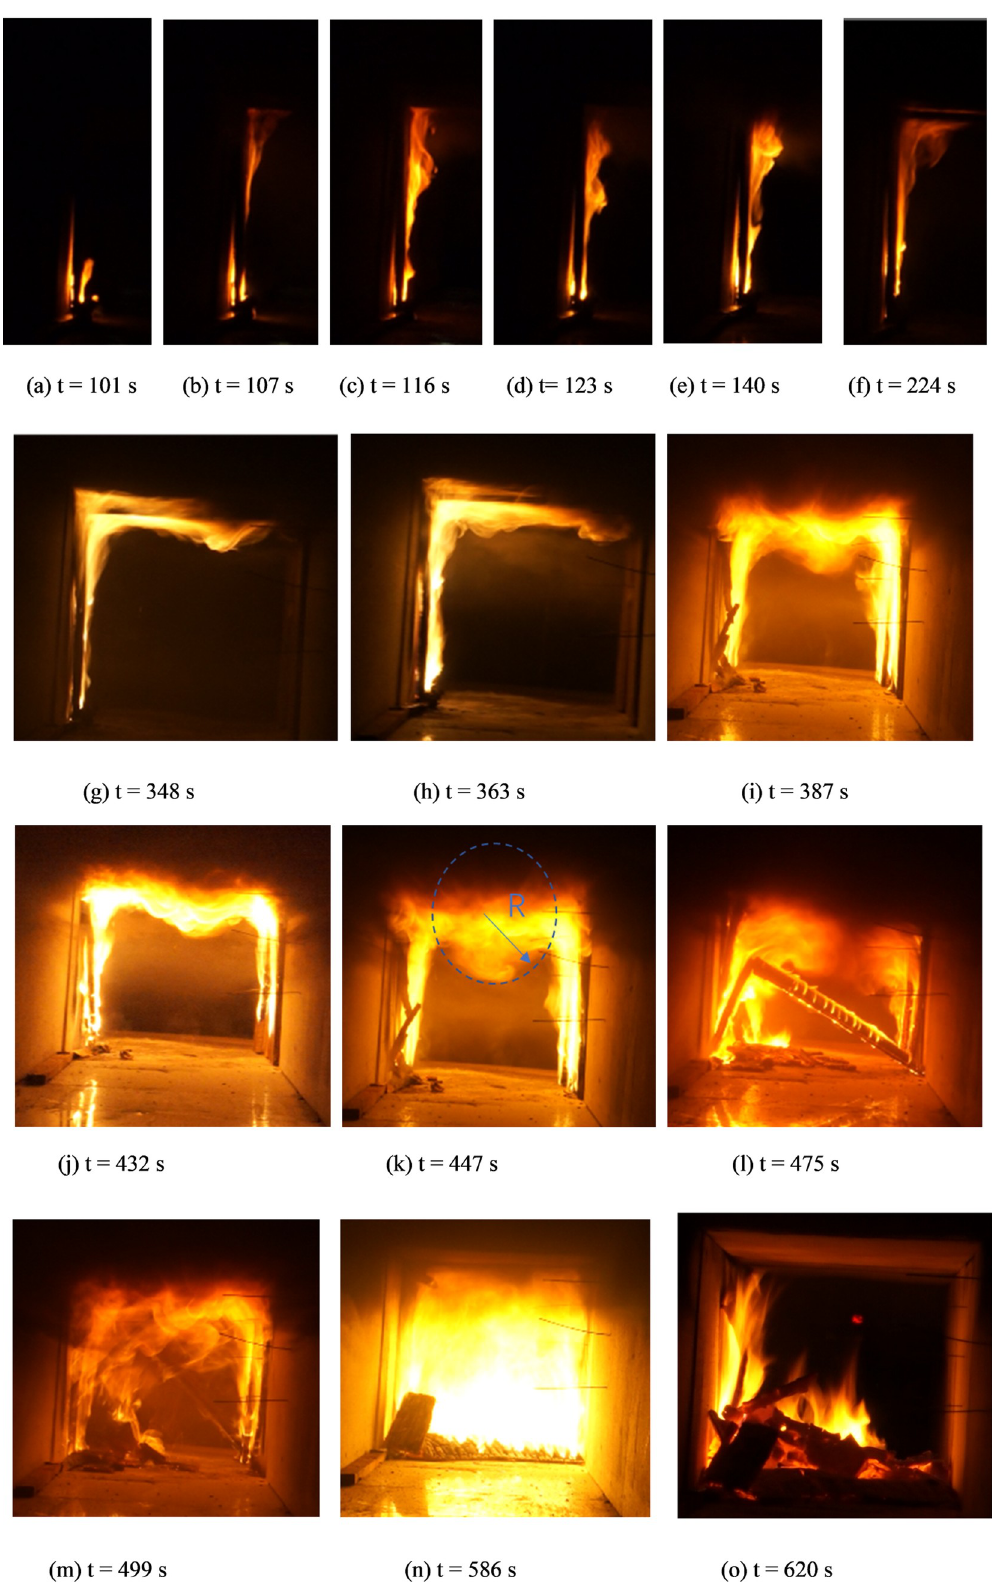
Fig 6. Flame morphology along timber lining during different fire